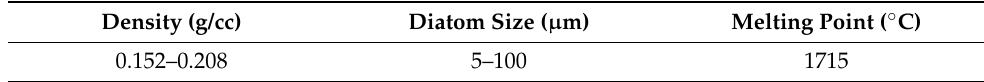
Table 2. Physical properties of DE.